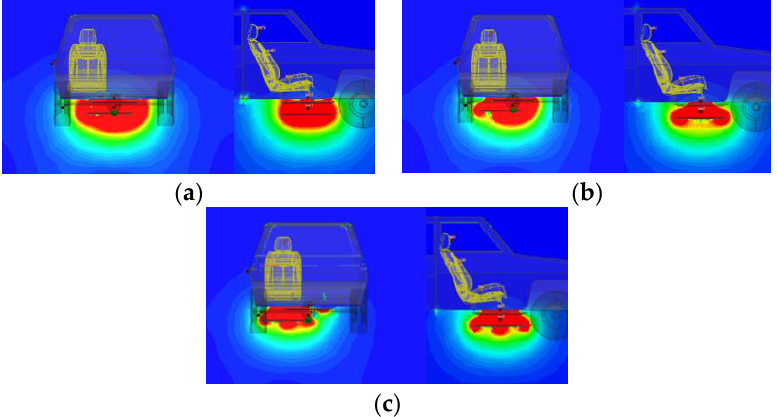
Figure 15. Magnetic field distribution: ( a ) 10% offset — 60 mm; ( b ) 30% offset — 180 mm; ( c ) 50% offset — 300 mm.